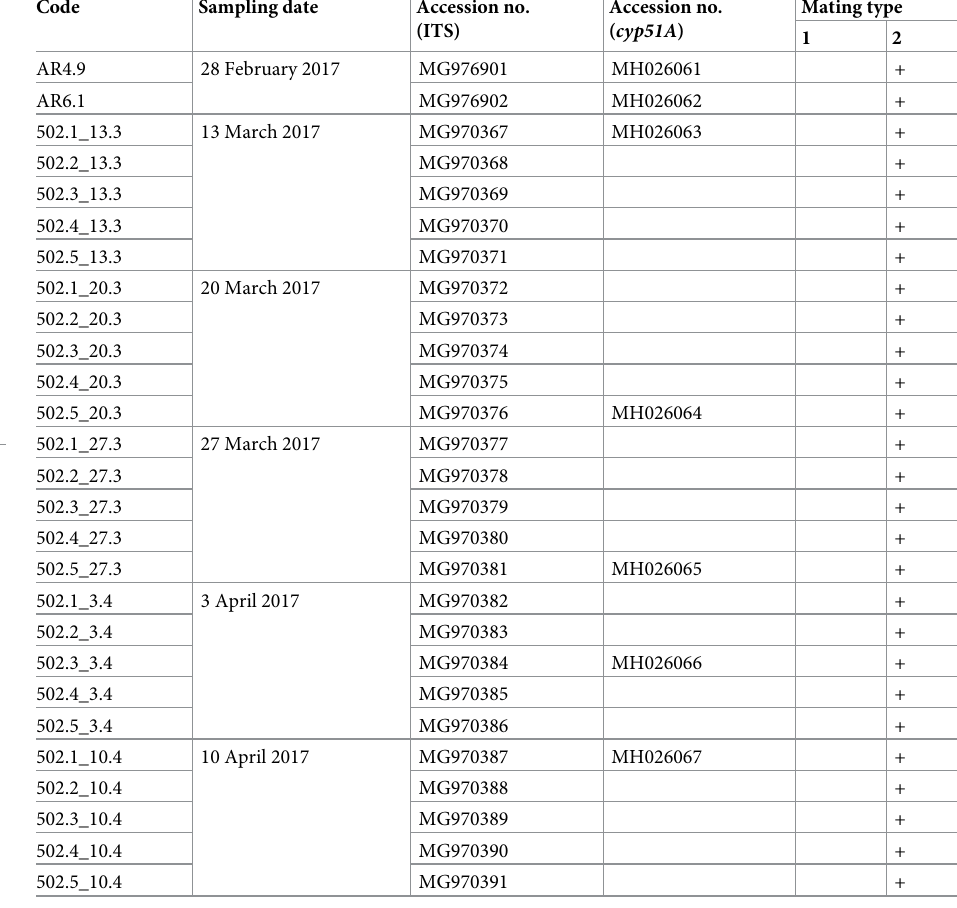
Table 1. List of A . fumigatus isolates selected for sensitivity assays with accession numbers and mating